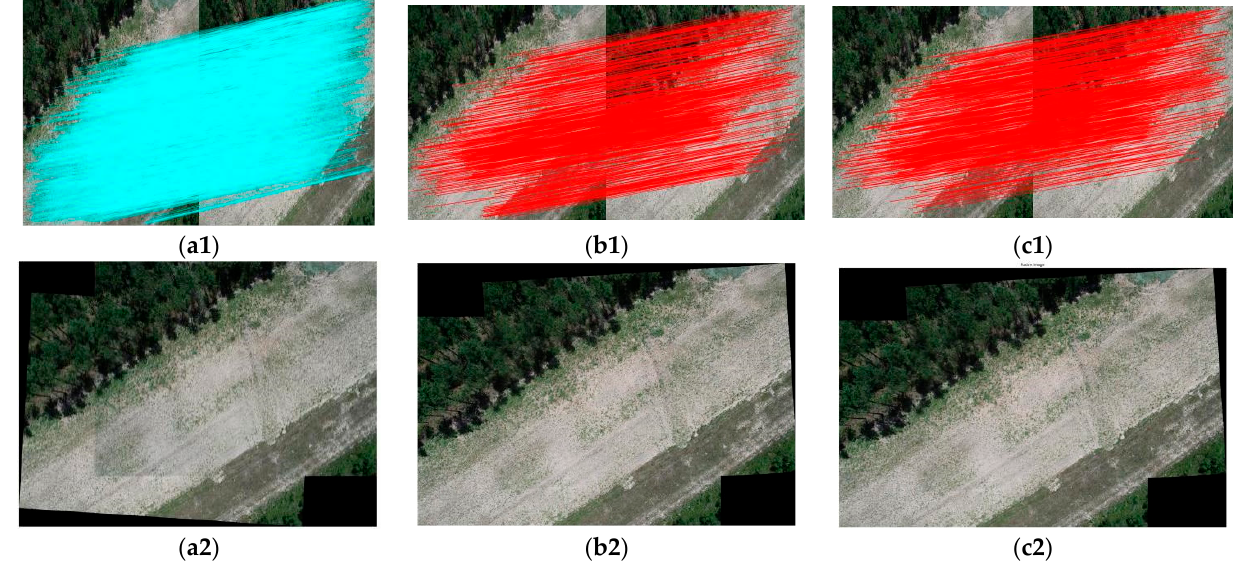
Figure 5. Feature matching and splicing effects on linear features in the forest road area. ( a1 ) Feature matching results of the SIFT algorithm. ( a2 ) Splicing effect of the SIFT algorithm. ( b1 ) Feature match- ing results of the SIFT-OCT algorithm. ( b2 ) Splicing effect of the SIFT-OCT algorithm. ( c1 ) Feature matching results of the optimized SIFT-OCT algorithm. ( c2 )Splicing effect of the optimized SIFT- OCT algorithm.